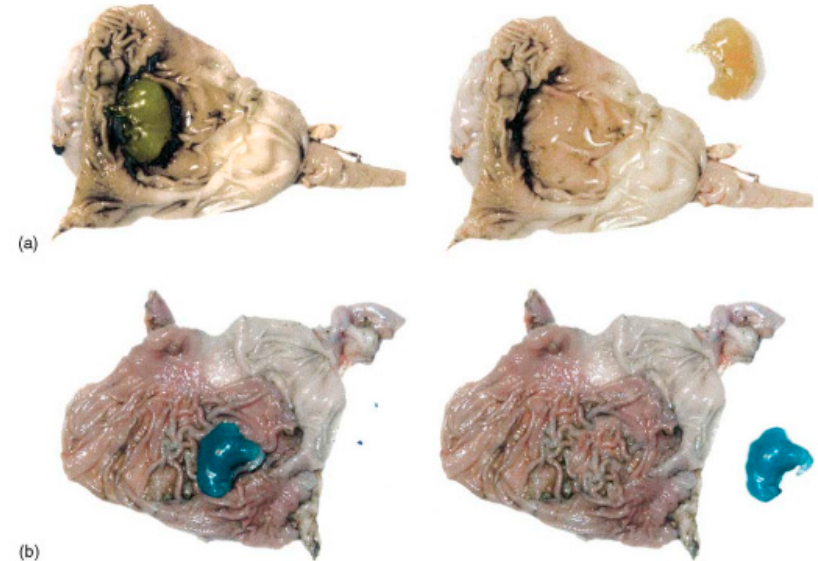
Figure 9. Photographs showing the presence of gels in rabbit stomach 5 h after oral administration of ( a ) a 1.0% ( w / v ) gellan sol and ( b ) a 1.5% ( w / v ) alginate sol. Reprinted with permission from [114]. Copyright 2022, Elsevier.